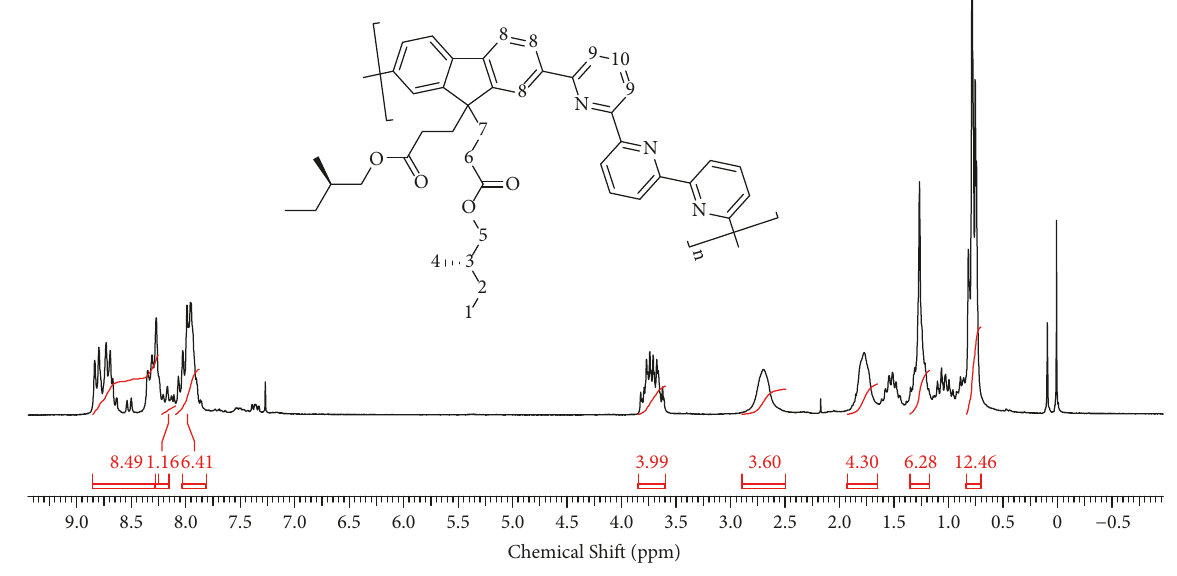
Figure 4: Assigned 1 H NMR spectrum of LaPPS71.